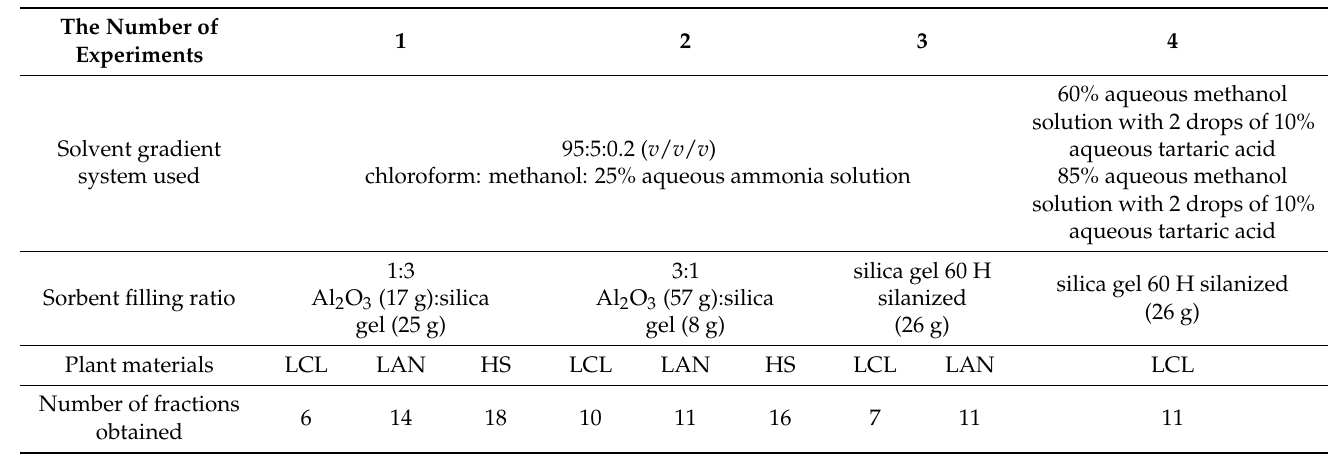
Table 1. Fractions obtained in experiments carried out for three plant species of the Lycopodiaceae family using different combinations of sorbents and different mobile phases using the VLC